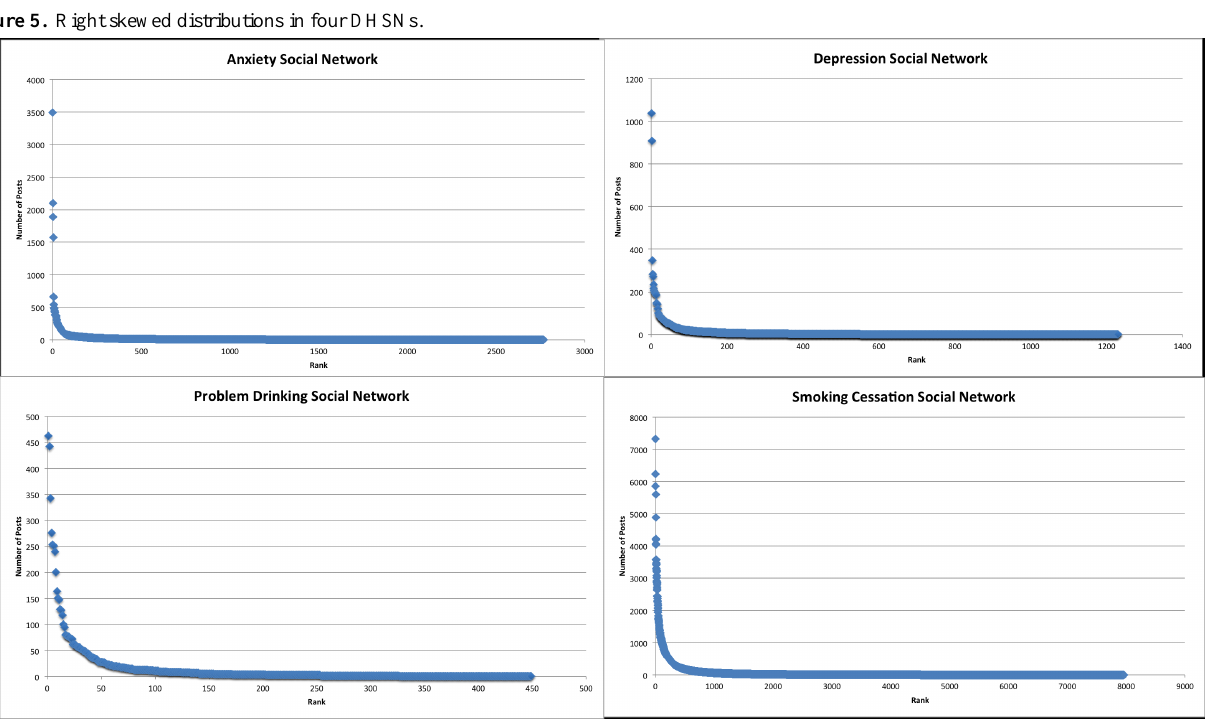
Figure 5. Right skewed distributions in four